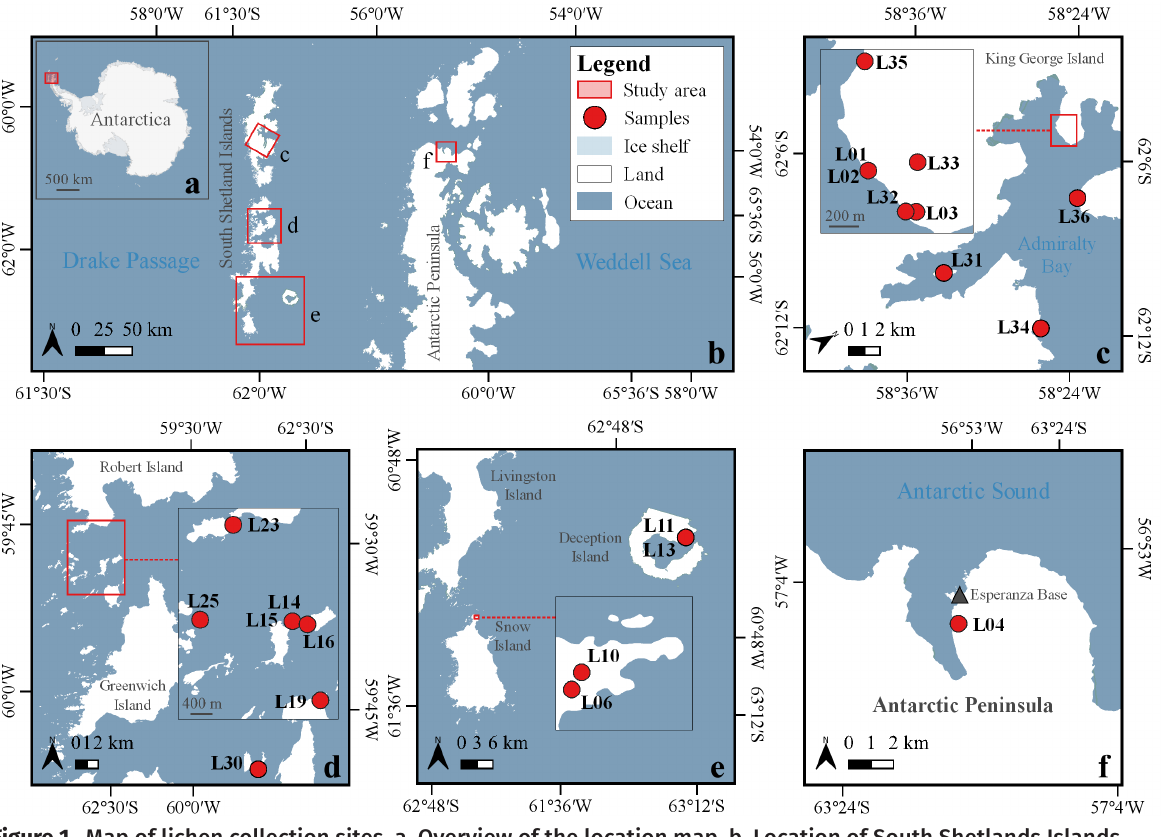
Figure 1. Map of lichen collection sites. a. Overview of the location map. b. Location of South Shetlands Islands and Antarctica Peninsula. c-f. Zoomed-in details of the sampling sites. *The map was generated using QGIS software (version 3.14.15; https://www.QGIS.org) and the SCAR Antarctic Digital Database (ADD version 7.0; http://www.add.scar.org). ** Cladonia metacorallifera (L30); Lecania brialmontii (L19); Mastodia tessellata (L14); Polycauliona regalis (L15); Polycauliona candelaria (L4, L6, L13); Rhizocarpon geographicum (L23); Sphaerophorus globosus (L10); Umbilicaria decussata (L16); Usnea antarctica (L36); Usnea aurantiacoatra (L1, L2, L3, L25, L31, L33, L34, L35); Usnea capillacea